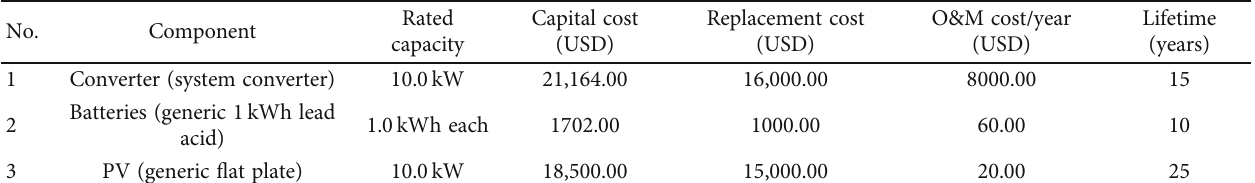
Table 5: Structure items and their expense for o ff -grid PV microgrid systems for the rural community.